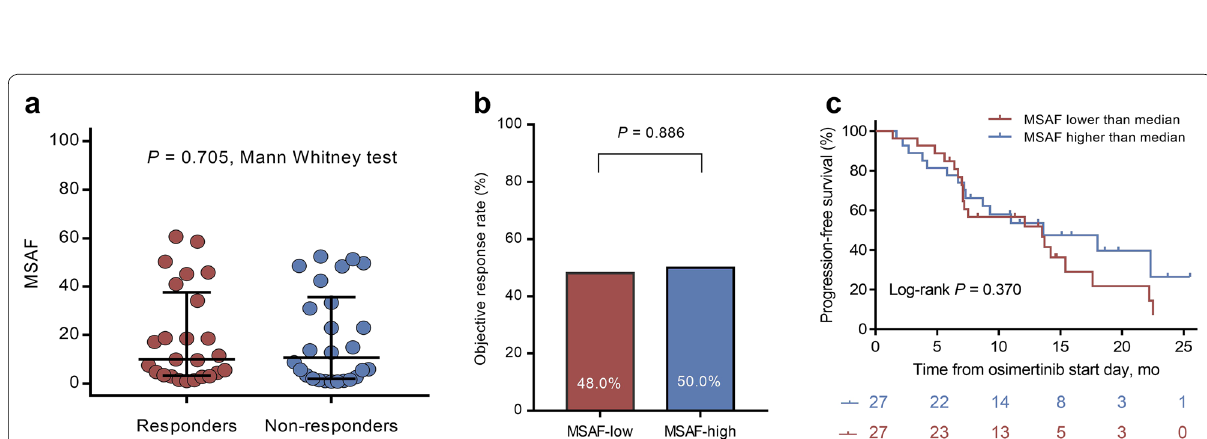
Fig. 2 Maximum somatic allele frequency (MSAF) and osimertinib treatment outcomes. a The MSAF level between responders and non-responders (median: 9.9% vs 10.7%, P 0.705, Mann–Whitney test). b Overall response rate between patients with MSAF-low and MSAF-high (48.0% vs 50.0%, = P 0.886, χ 2 test), according to the median value of MSAF. c Progression-free survival stratified by MSAF-low and MSAF-high patients ( P = log-rank